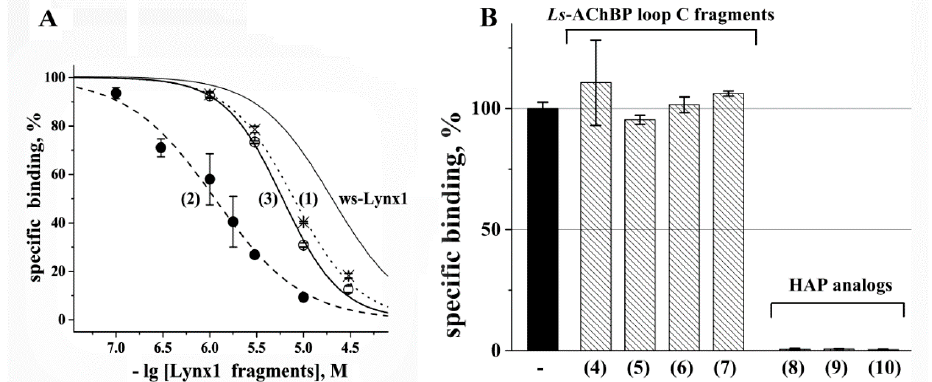
Figure 1. Characterization of binding activity of synthesized peptide fragments by competitive radioligand analysis using 125 I- α -Bgt as a radioligand. ( A ) Inhibition curves for Lynx1 loop II fragments on T. californica nAChR. Crosses, full circles and open circles indicate the data points for compounds (1)–(3), respectively. Each point is the mean ± SEM value of two measurements for each concentration in two independent experiments. The calculated IC 50 values (mean ± SEM) for pep- tides 1-3 were 7.9 ± 0.2, 1.1 ± 0.1 and 6.0 ± 0.2 μ M, respectively. For comparison, the inhibition curve for ws-Lynx1 (no symbols) on the same receptor under the same conditions (IC 50 24 μ M) is shown [26]. ( B ) Bar graph presentation of the decrease in specific binding of 125 I- α -Bgt to T. californica nAChR in the presence of L. stagnalis AChBP loop C and HAP analogs. Concentration of peptides (4)–(10) was 10 µ M at which no “inhibition” for loop C fragments (102 ± 7 % of specific binding) and complete “inhibition” for HAP analogs (0.6 ± 0.1 % of specific binding) was revealed. The specific binding in the absence of peptides is accepted as 100%. Data are presented as mean ± SEM.